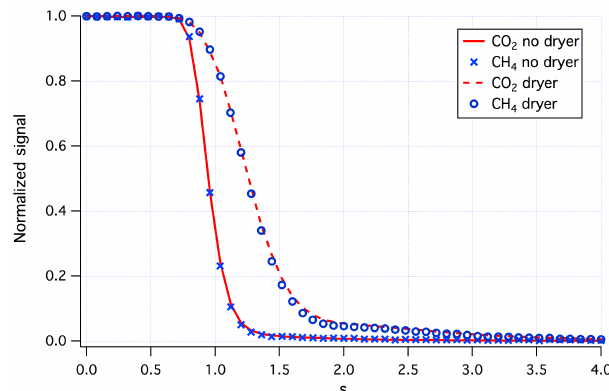
Figure 8. Fall offs in the Picarro dry CO 2 and CH 4 signals shortly after reductions in the calibration gas flow rate. The use of a Nafion dryer increases the observed response time by about 0.3s.